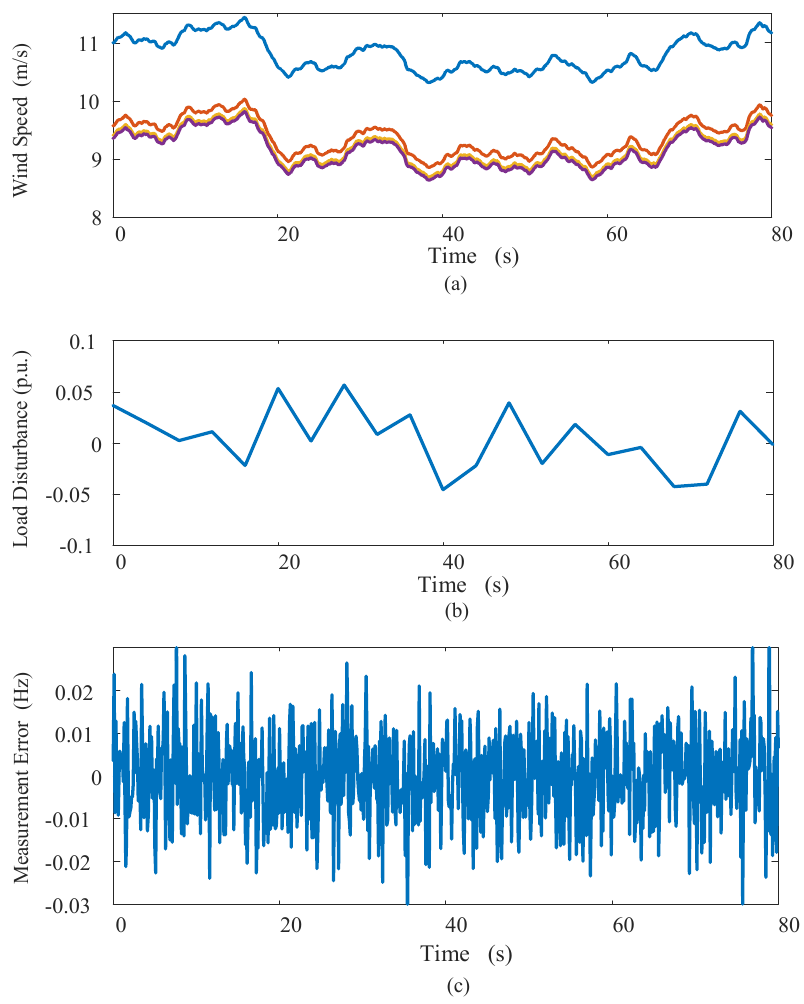
Figure 14. Disturbances: ( a ) wind disturbance; ( b ) load disturbance; ( c ) frequency measurement er- ror.